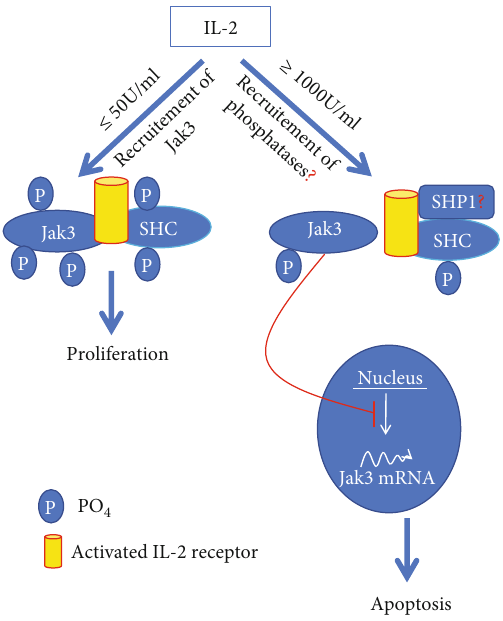
Figure 3: Proposed model of IL-2-induced intestinal epithelial homeostasis